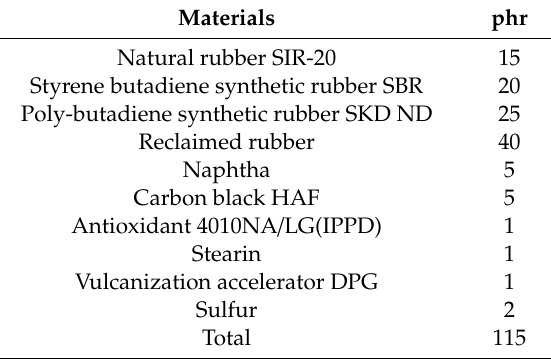
Table 2. The rubber structure from the